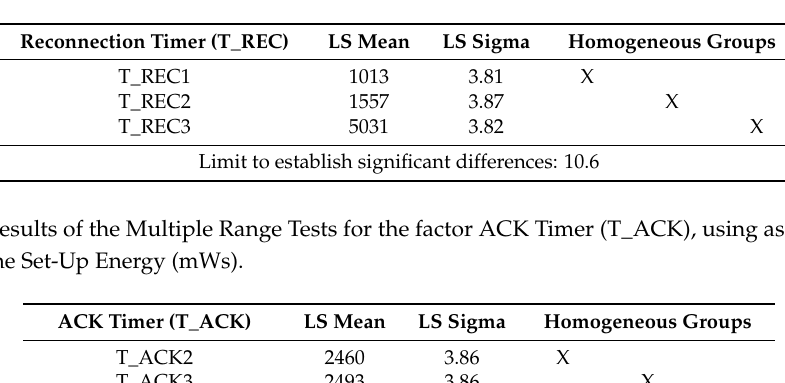
Table 7. Results of the Multiple Range Tests for the factor Reconnection Timer (T_REC), using as dependent variable the Set-Up Energy (mWs).